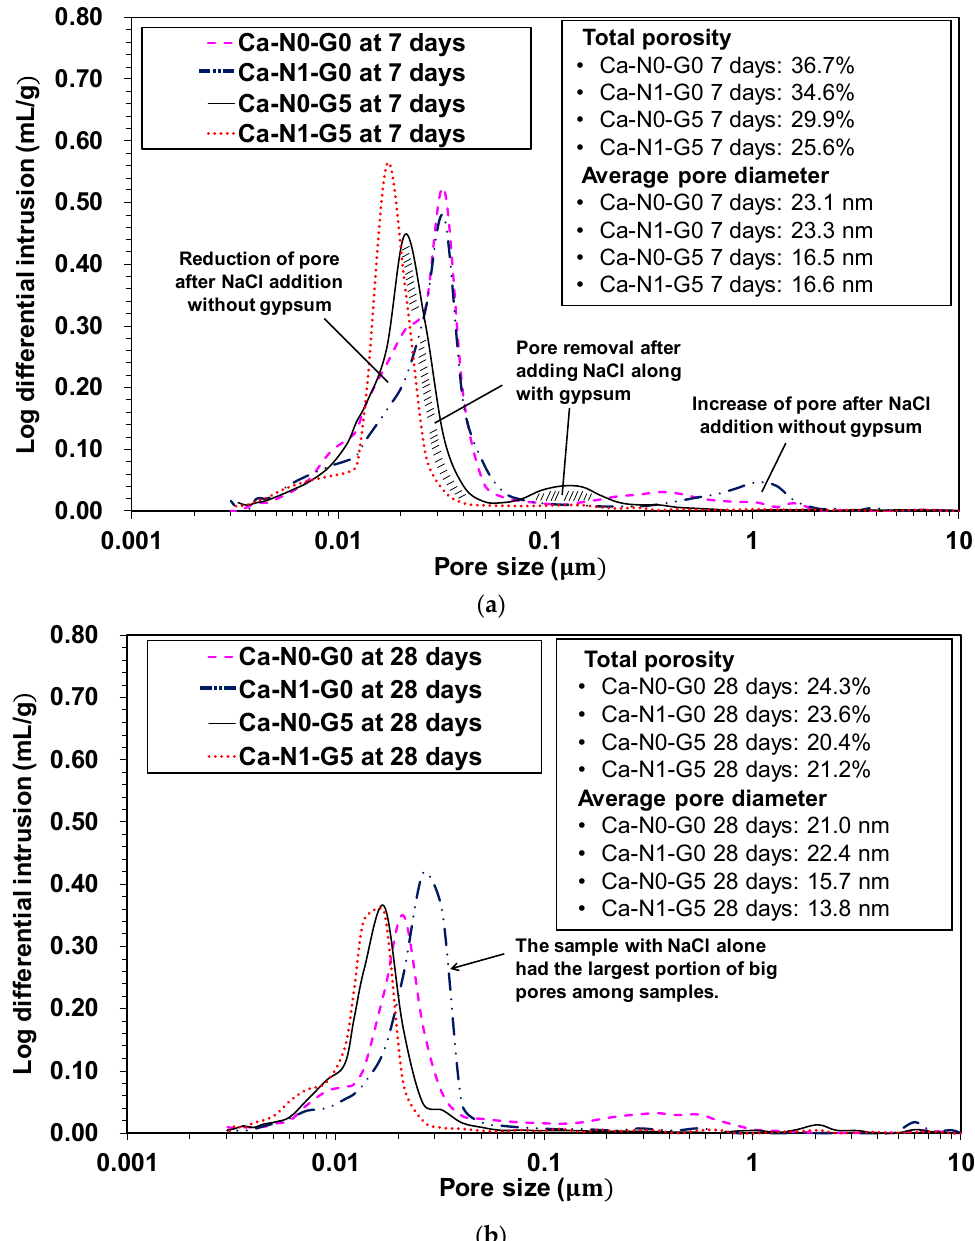
Figure 5. Mercury intrusion porosimetry (MIP) results of hardened paste samples at ( a ) 7 days and ( b ) 28 days.